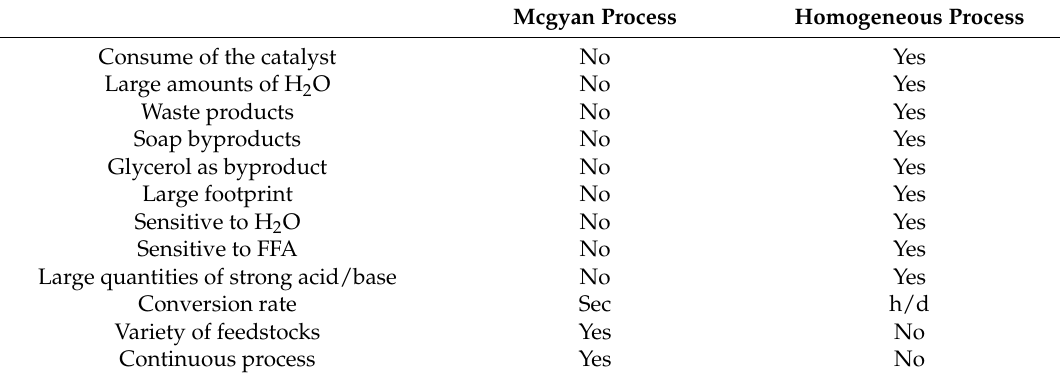
Figure 14. Process flow diagram of a biodiesel plant based on the Mcgyan process (Copyright of Elsevier, see [47]). EFAR: Easy Fatty Acid Removal. Table 16. A comparison of the supercritical fixed–bed continuous flow process (the Mcgyan process) to the conventional homogeneously base catalyzed batch system.